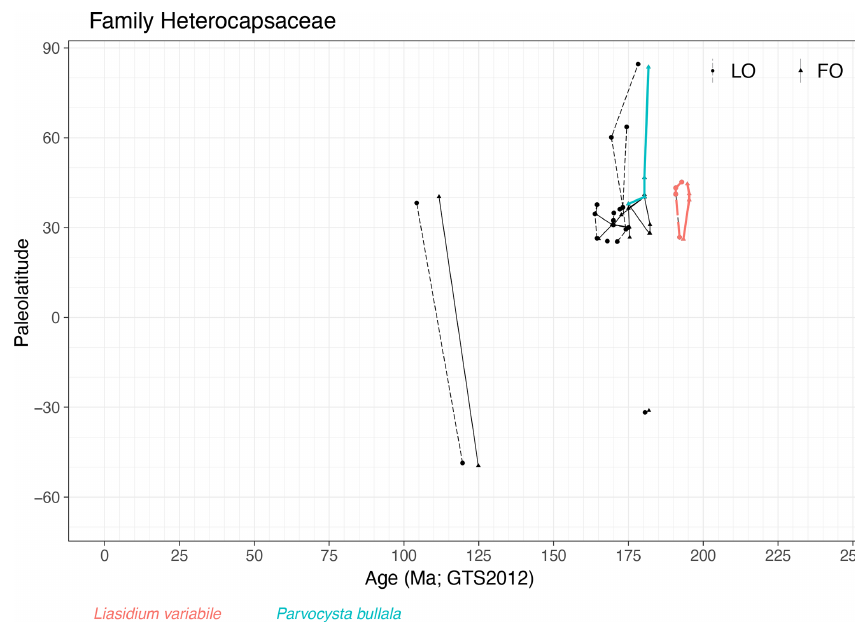
Figure 20. Same as Fig. 5 but for the family